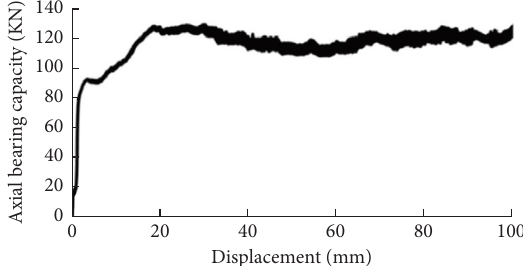
Figure 13: Axial load-displacement relation curve of a U -type steel lap joint.